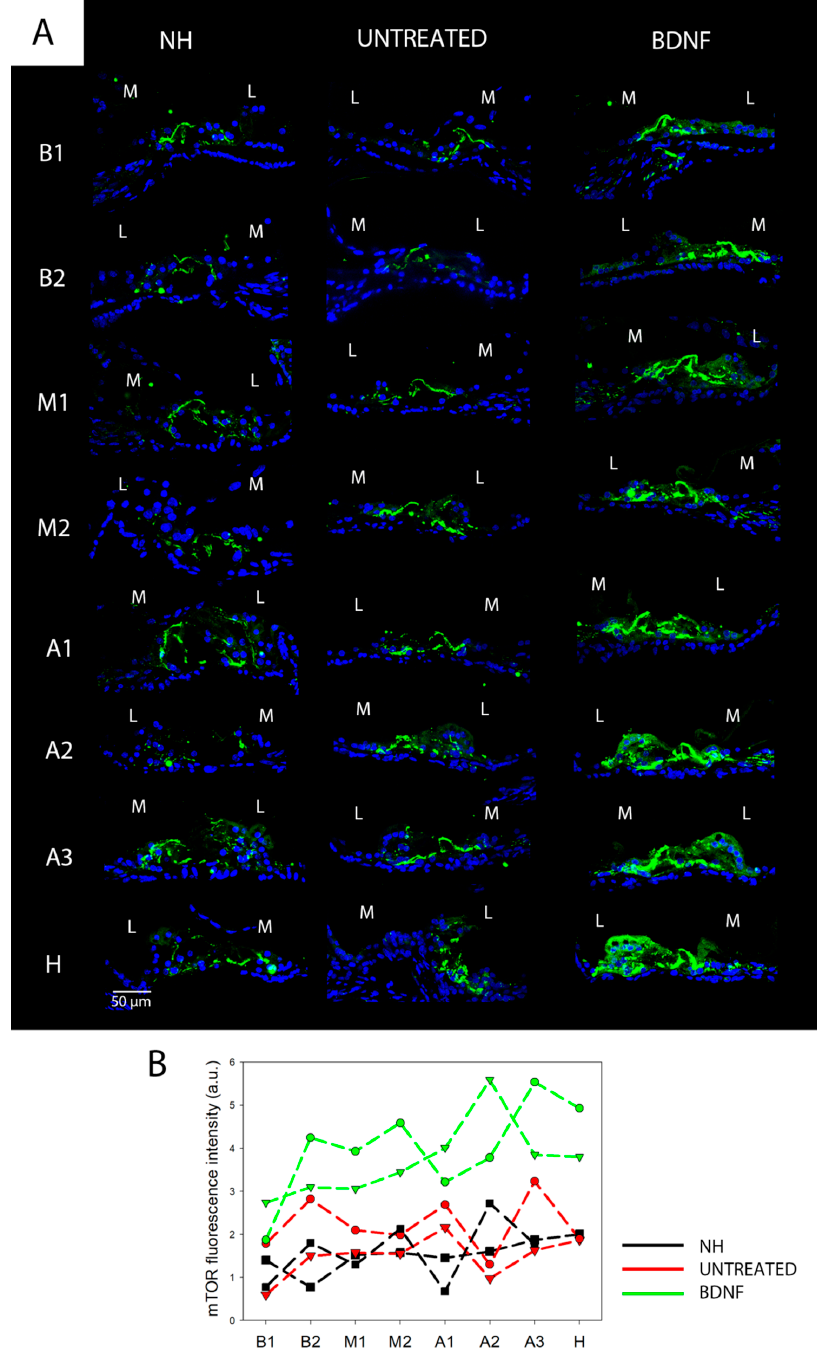
Figure 10. Immunolocalization and fluorescence intensity of mTOR. ( A ) Representative confocal images showing the organ of Corti immunolabelled with anti-mTOR (green) and counterstained with bisbenzimide nuclear dye (blue) of all experimental groups and for each cochlear location (from B1 to H). Scale bar: 50 µm. L: lateral, M: medial. ( B ) Fluorescence intensity analysis of mTOR immunostaining. The graph shows the signal intensity of each sample for all cochlear locations (black: NH, red: untreated, green: BDNF-treated). The same symbol was used to identify the BDNF- treated and untreated ears of individual animals.